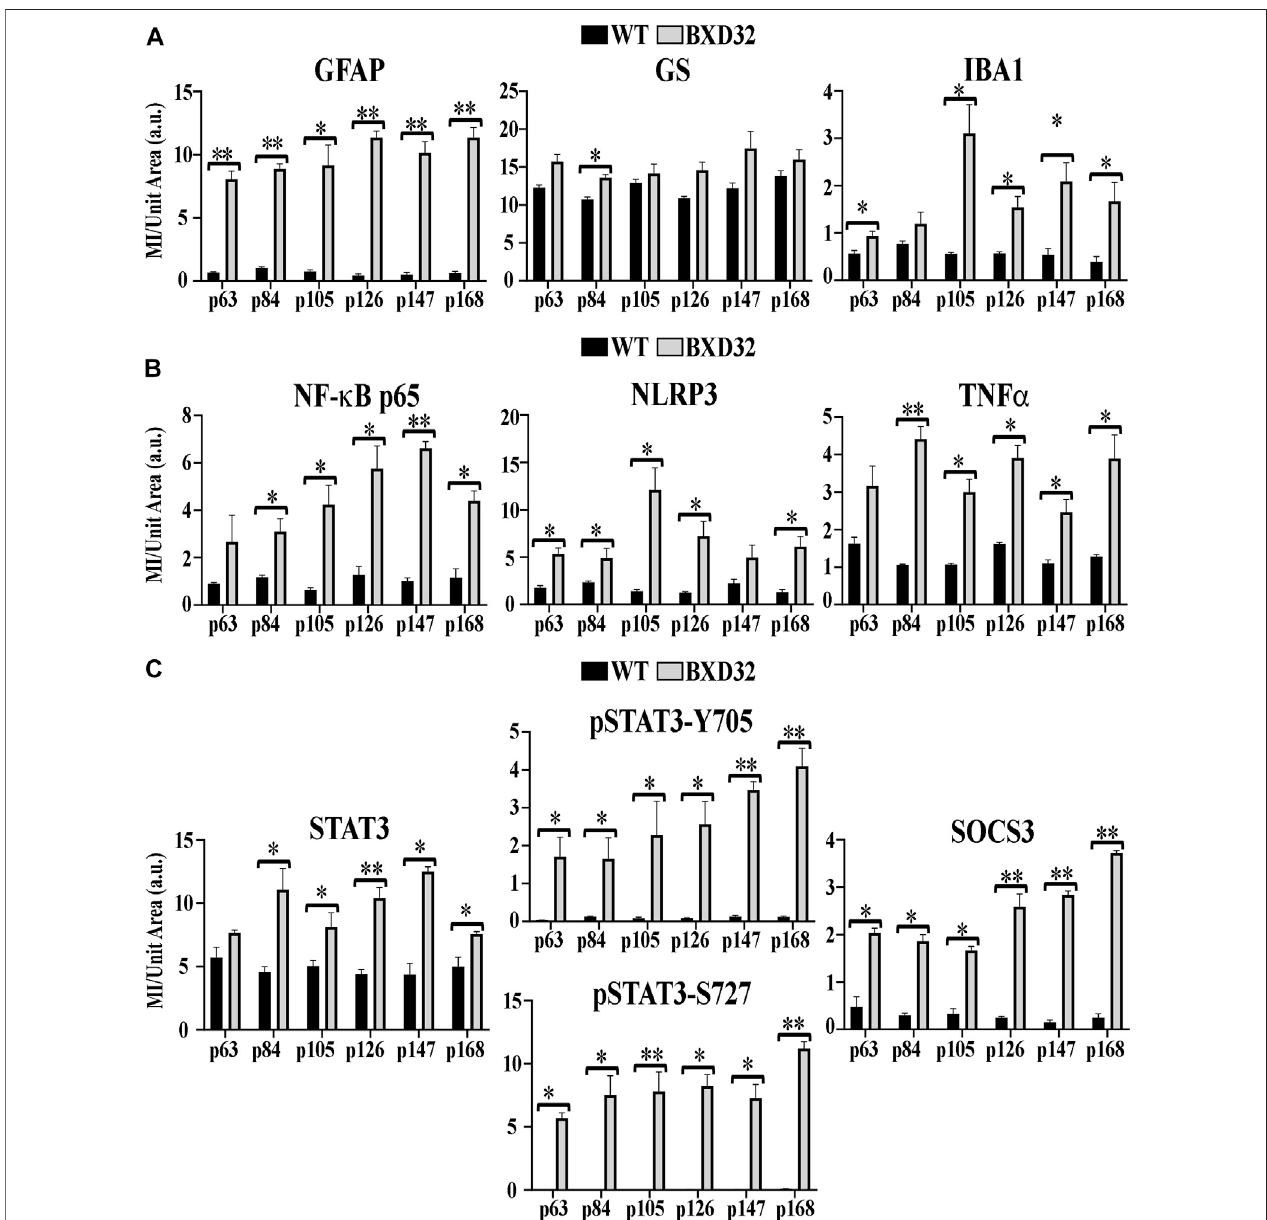
FIGURE 10 | Quanti fi cation of fIHC. Using ImageJ, mean intensity (MI) per unit area in arbitrary units (a.u.) was assessed for fIHC labeling of GFAP, GS, and IBA1 (A) ; NF- κ B, NLRP3, and TNF α (B) ; and STAT3, pSTAT3-Y705 and S727, and SOCS3 (C) in WT (black) and BXD32 (grey) mouse retinas with age. Error bars = ±SEM. *, p < 0.05; **, p <